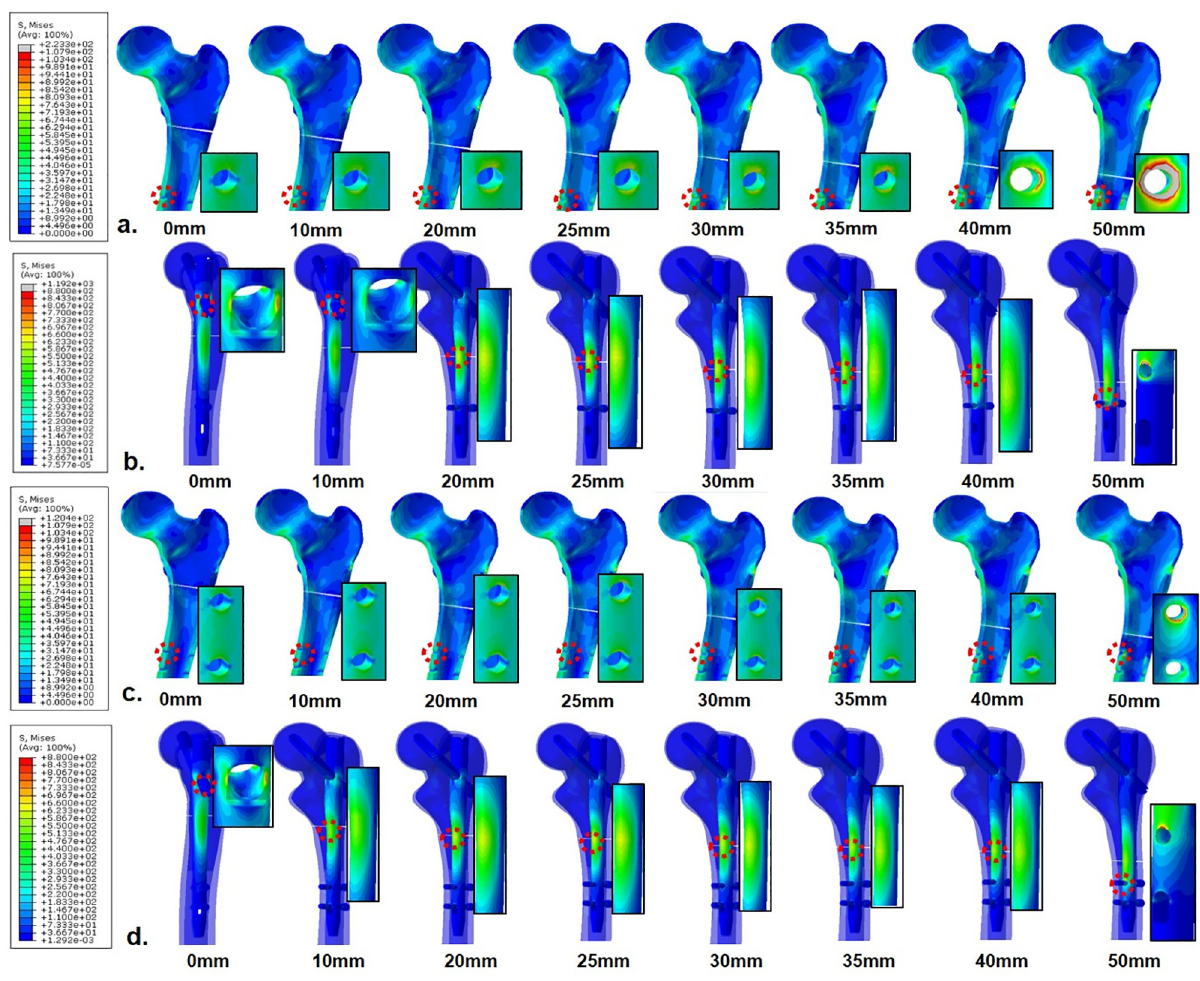
Fig 3. Stress distribution around the cortical bone and implant of finite element models using 1 (a, b) and 2 (c, d) distal screw fixation in 1 mm fracture gap, osteoporotic bone. The enlarged image portion represents the point at which the peak stress was observed.